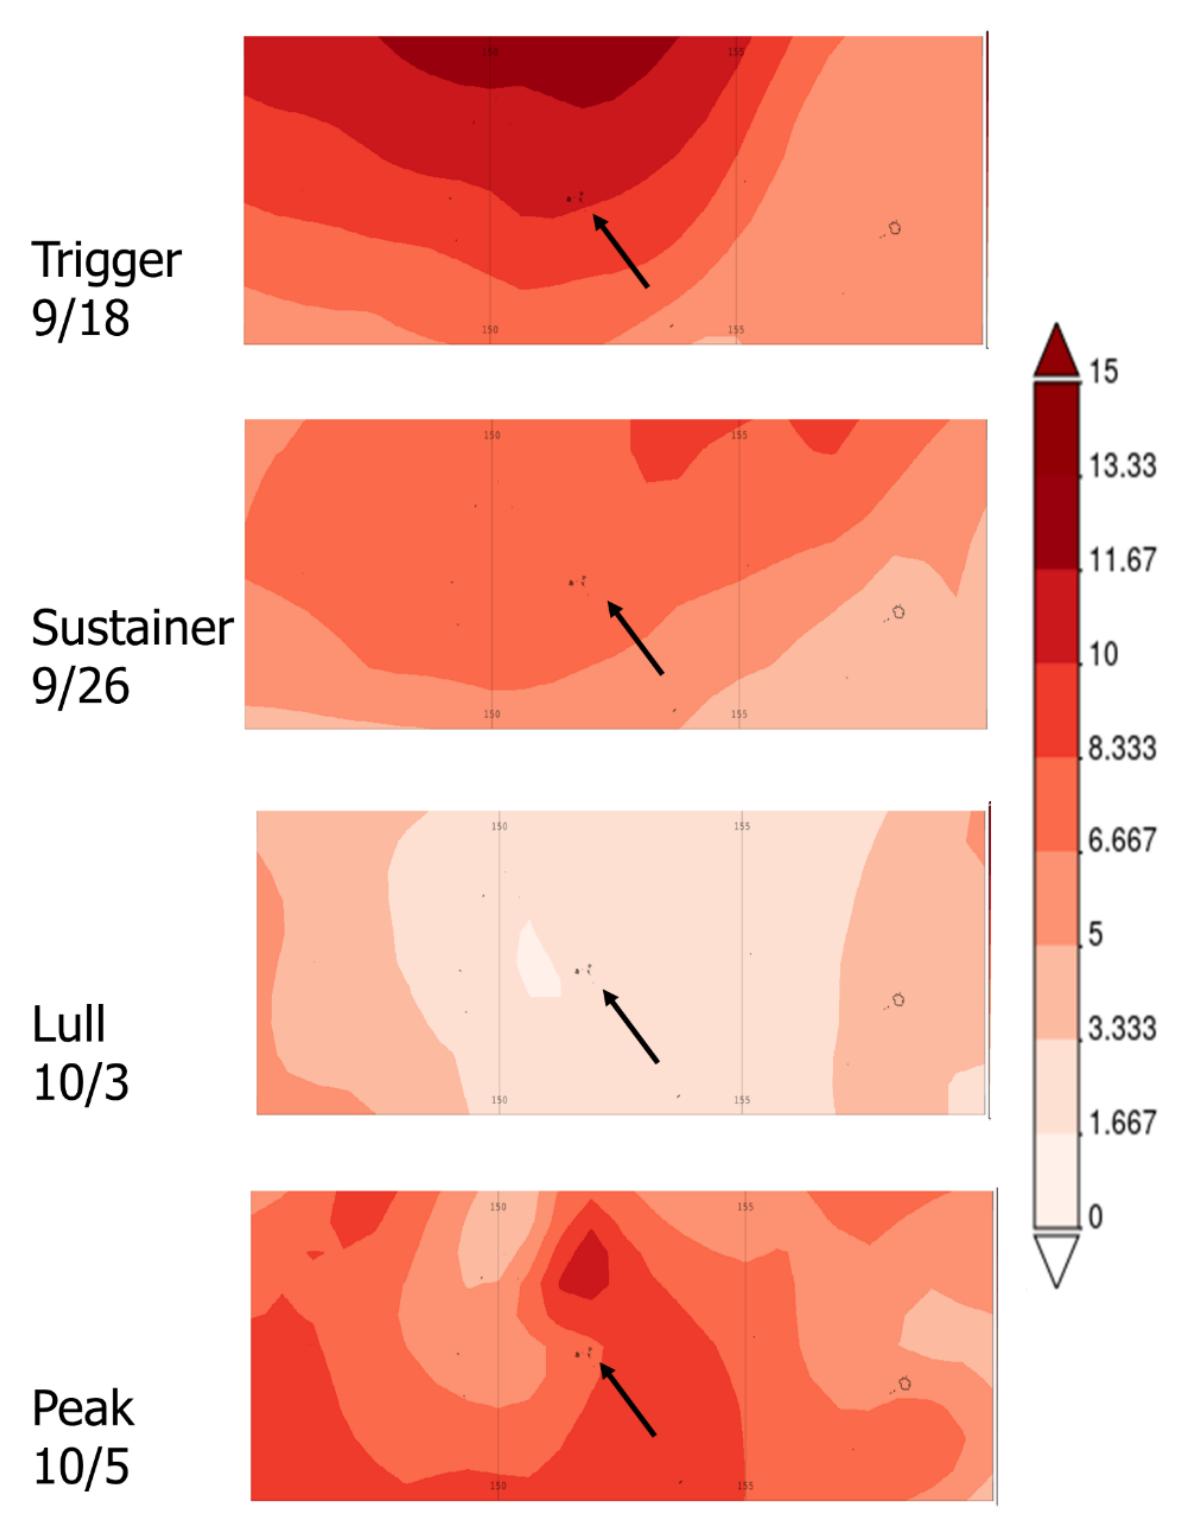
Figure 9. Time-averaged maps of MERRA-2 surface maximum windspeed for the four events of the wind sequence described for the October 2013 bloom event. The location of Chuuk Lagoon is indicated with the arrow. The region shown is 145–160 ◦ E, 5–10 ◦ N. Units are m/s.